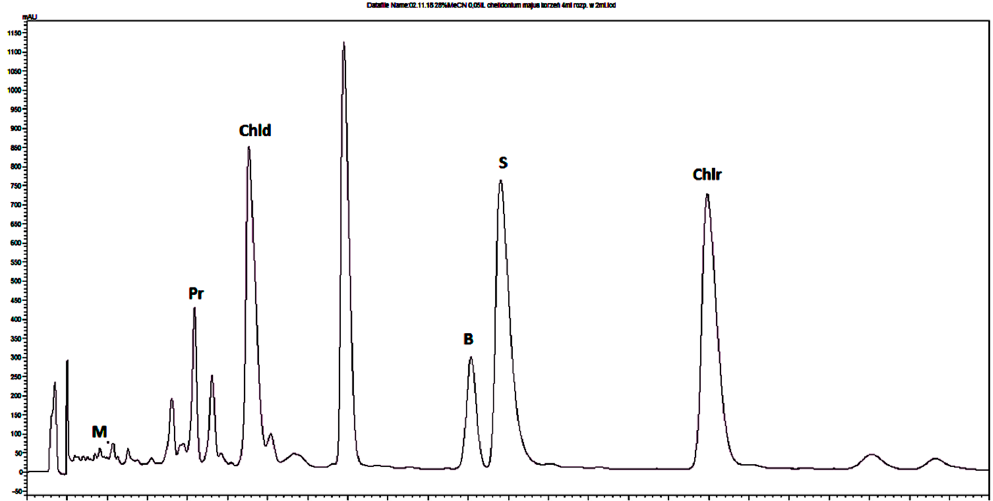
Figure 1. Chromatogram obtained for Chelidonium majus root extract obtained on Polar RP column with mobile phase containing 28% MeCN, water and 0.04 ML − 1 IL. Abbreviations: M-magnoflorine, Pr-protopine, Chld-chelidonine, B-berberine, S-sanquinarine, Chlr-chelerythrine.